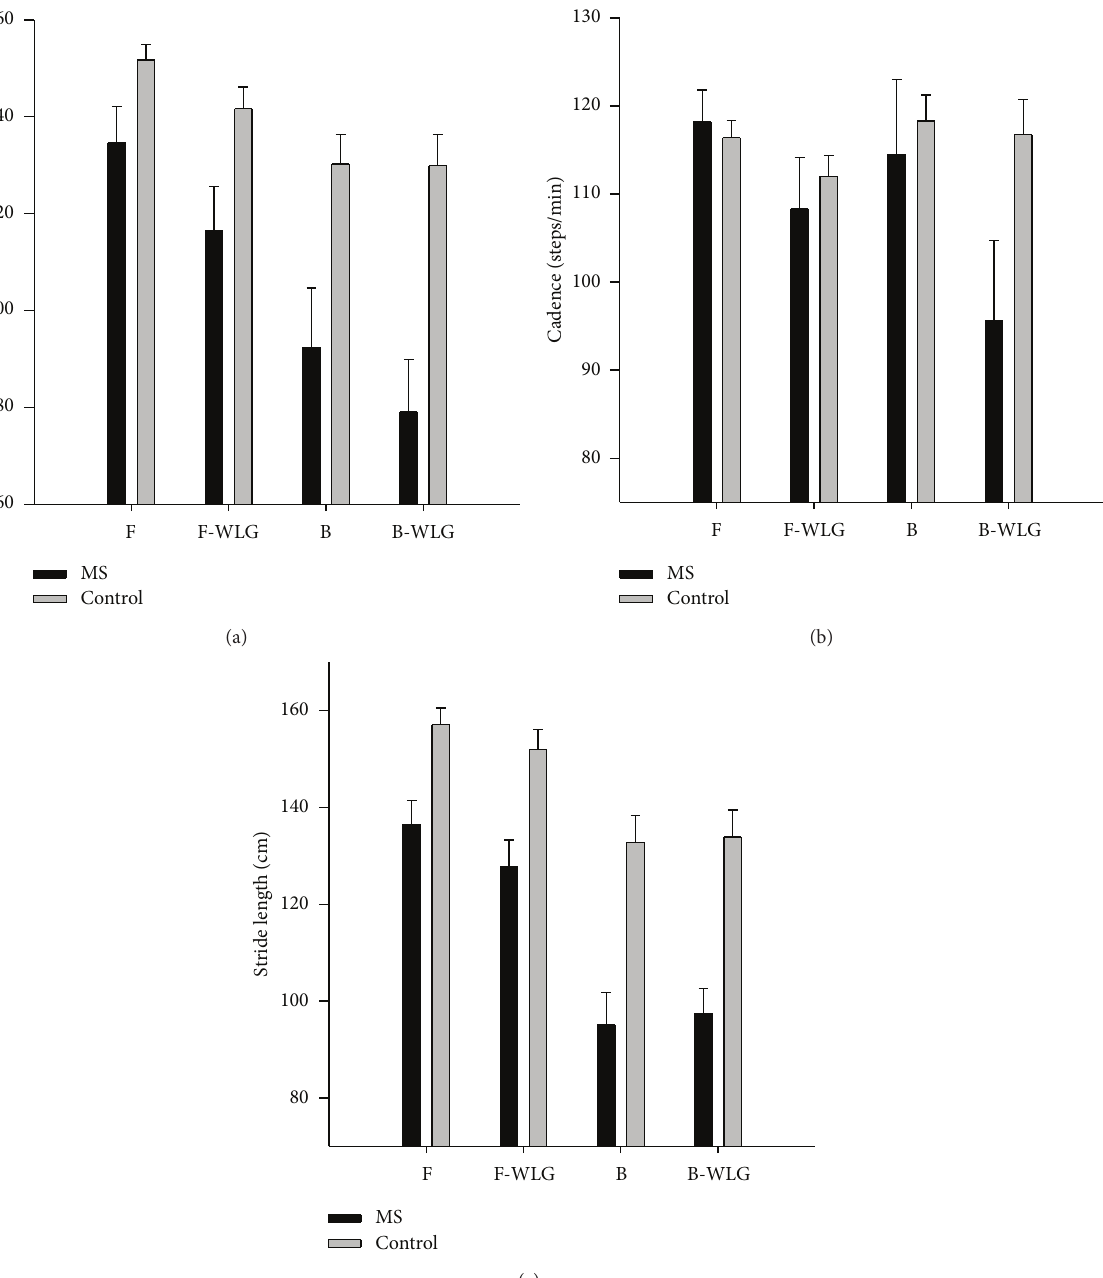
Figure 1: Walking velocity (a), cadence (b), and stride length (c) as a function of walking direction and group.